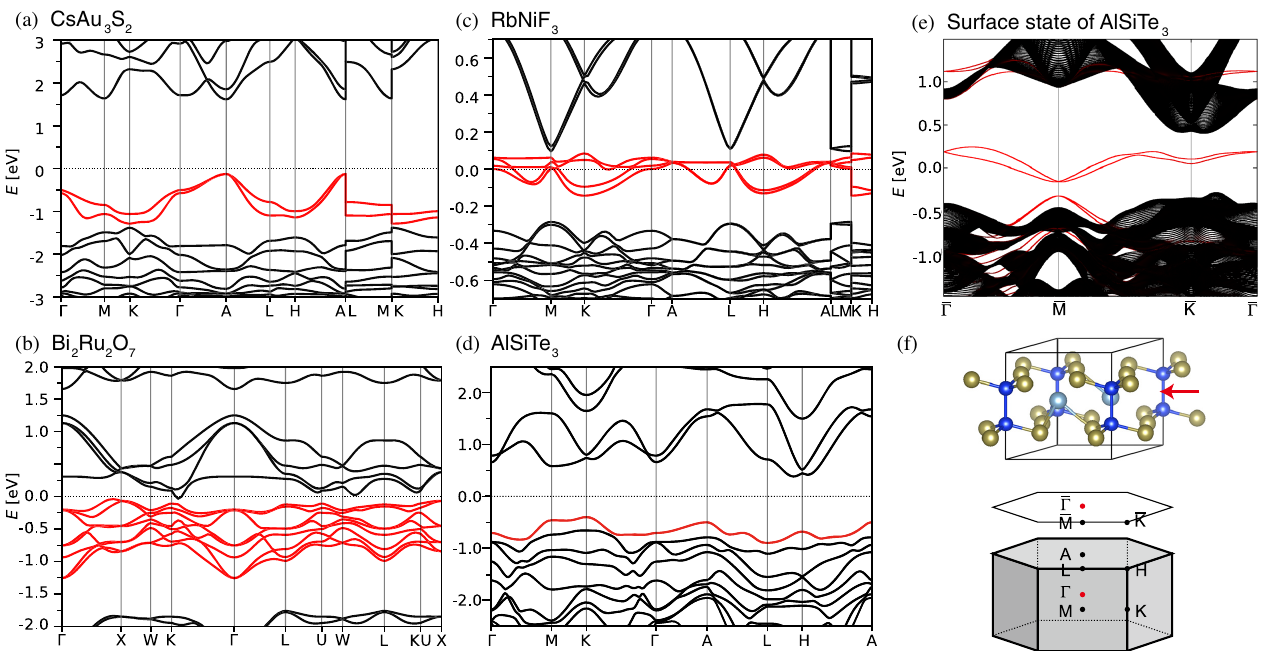
¯3 m 1 ). (b) Bi 2 Ru 2 O 7